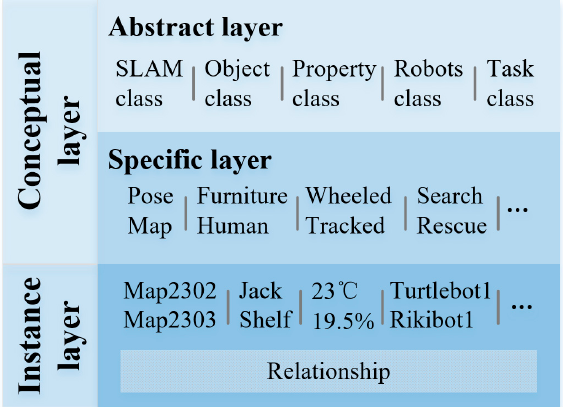
Figure 2. The classification of different layers in ontology.